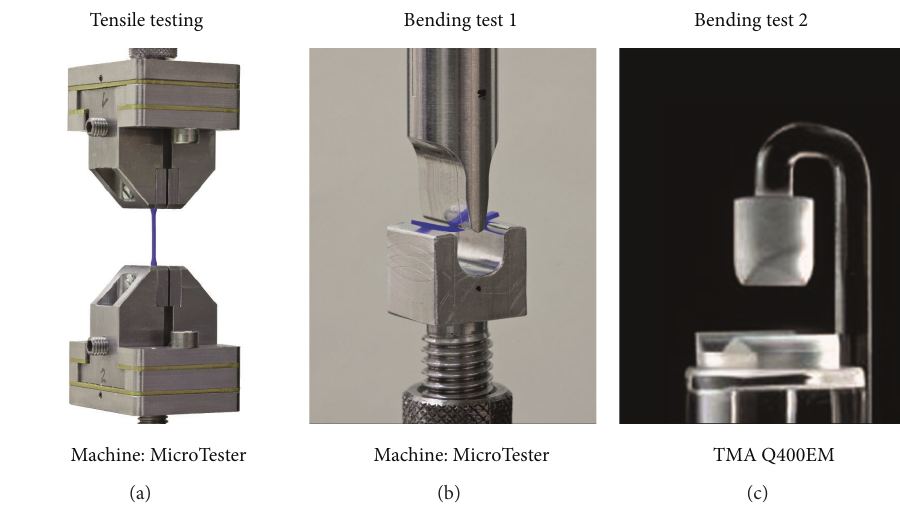
Figure 3: Setup of the different testing methods (clamping devices for the tensile test (a) and bending test 1 (b) used Instron MicroTester and bending test 2 used TMA Q400EM (c)).